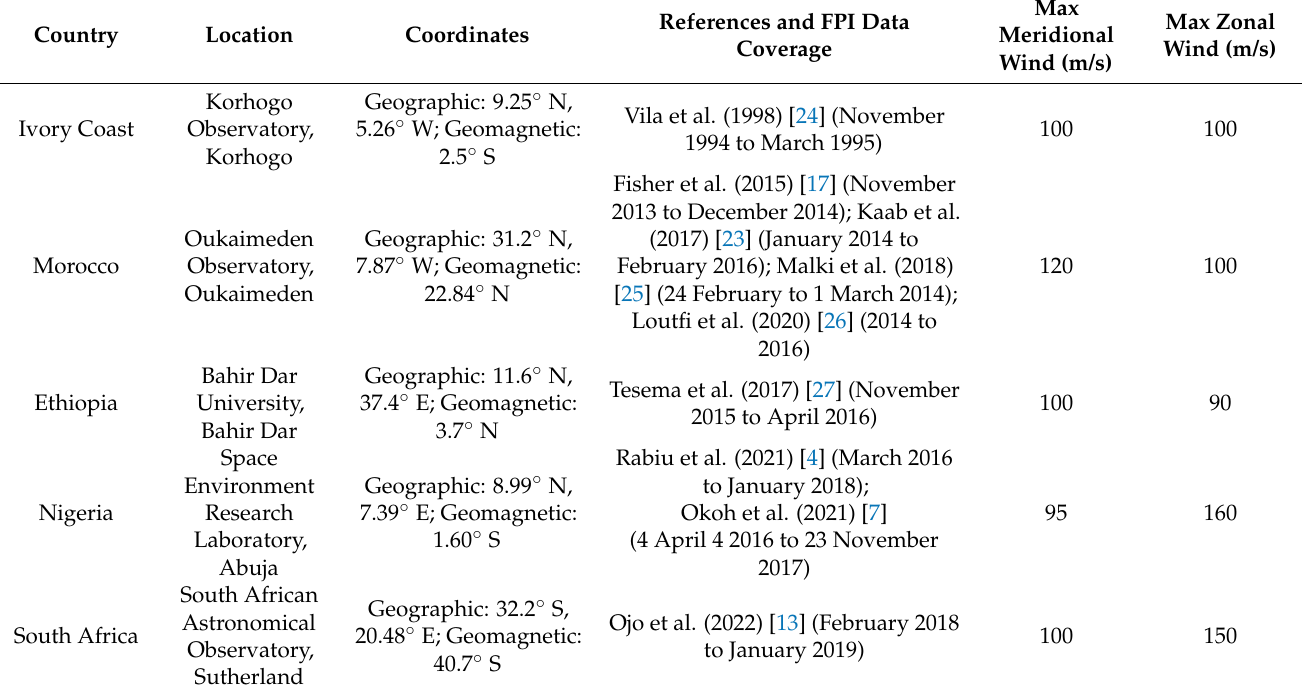
Table 1. List of locations in Africa where FPI studies of thermospheric neutral winds were conducted, and comparisons of maximum thermospheric winds observed. The maximum winds presented are maximum magnitudes, not signed